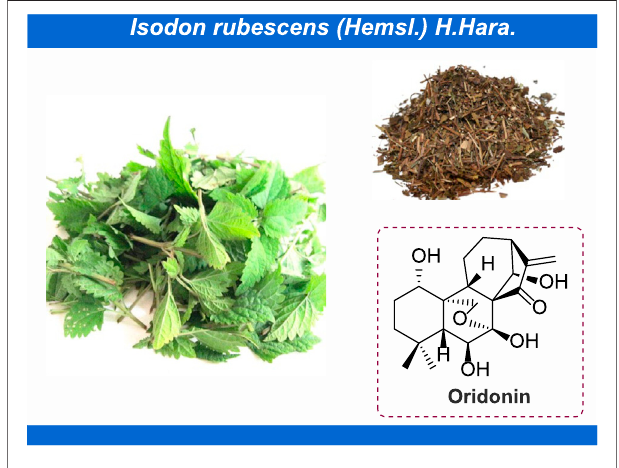
FIGURE 1 | Oridonin isolated from Isodon rubescens (Hemsl.)